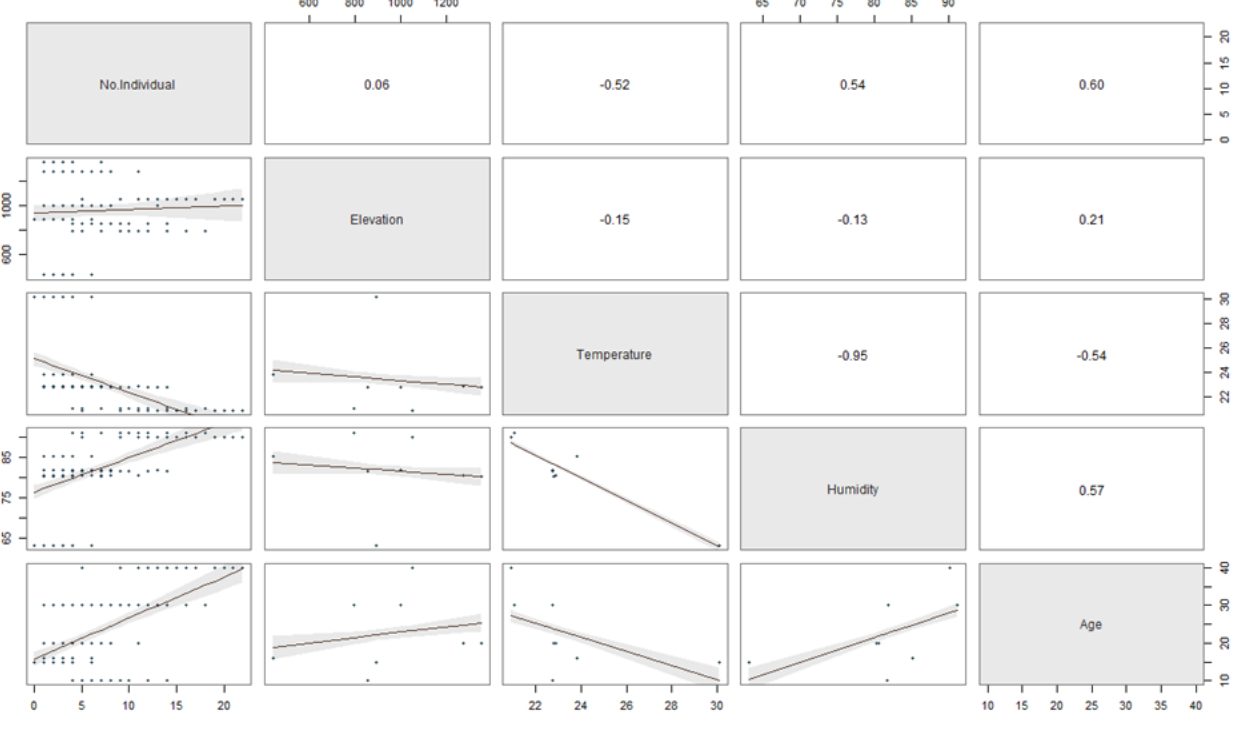
Figure 5. The scatter plot matrix describes the multiple regression between the stand-age, elevation, temperature, and humidity to the number of ambrosia beetle individuals.